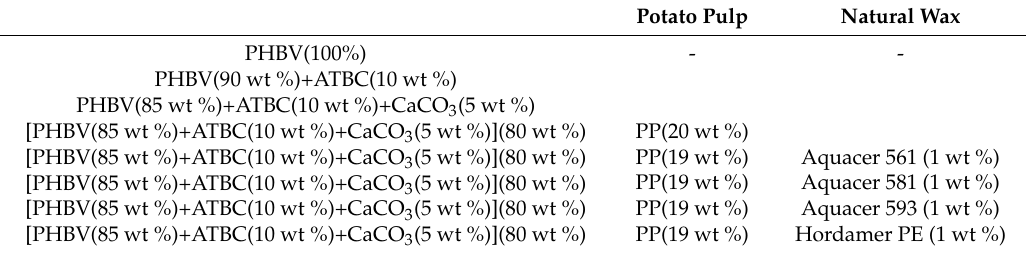
Table 1. Composition of the PHBV based matrix and